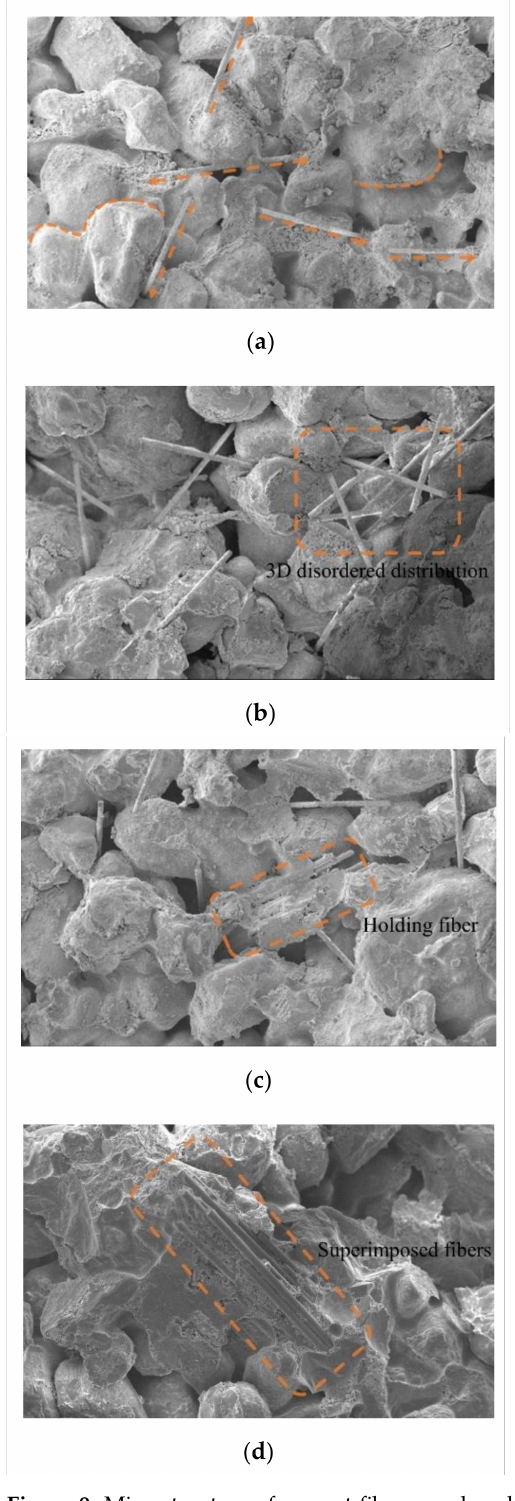
Figure 9. Microstructure of cement-fiber-cured aeolian sand. ( a ) SEM images of 6 mm fiber samples doped at 2‰ (100 × ); ( b ) SEM images of 6 mm fiber samples doped at 3‰ (100 × ); ( c ) SEM images of 6 mm fiber samples doped at 4‰ (100 × ); ( d ) SEM images of 6 mm fiber samples doped at 6‰ (100 ×